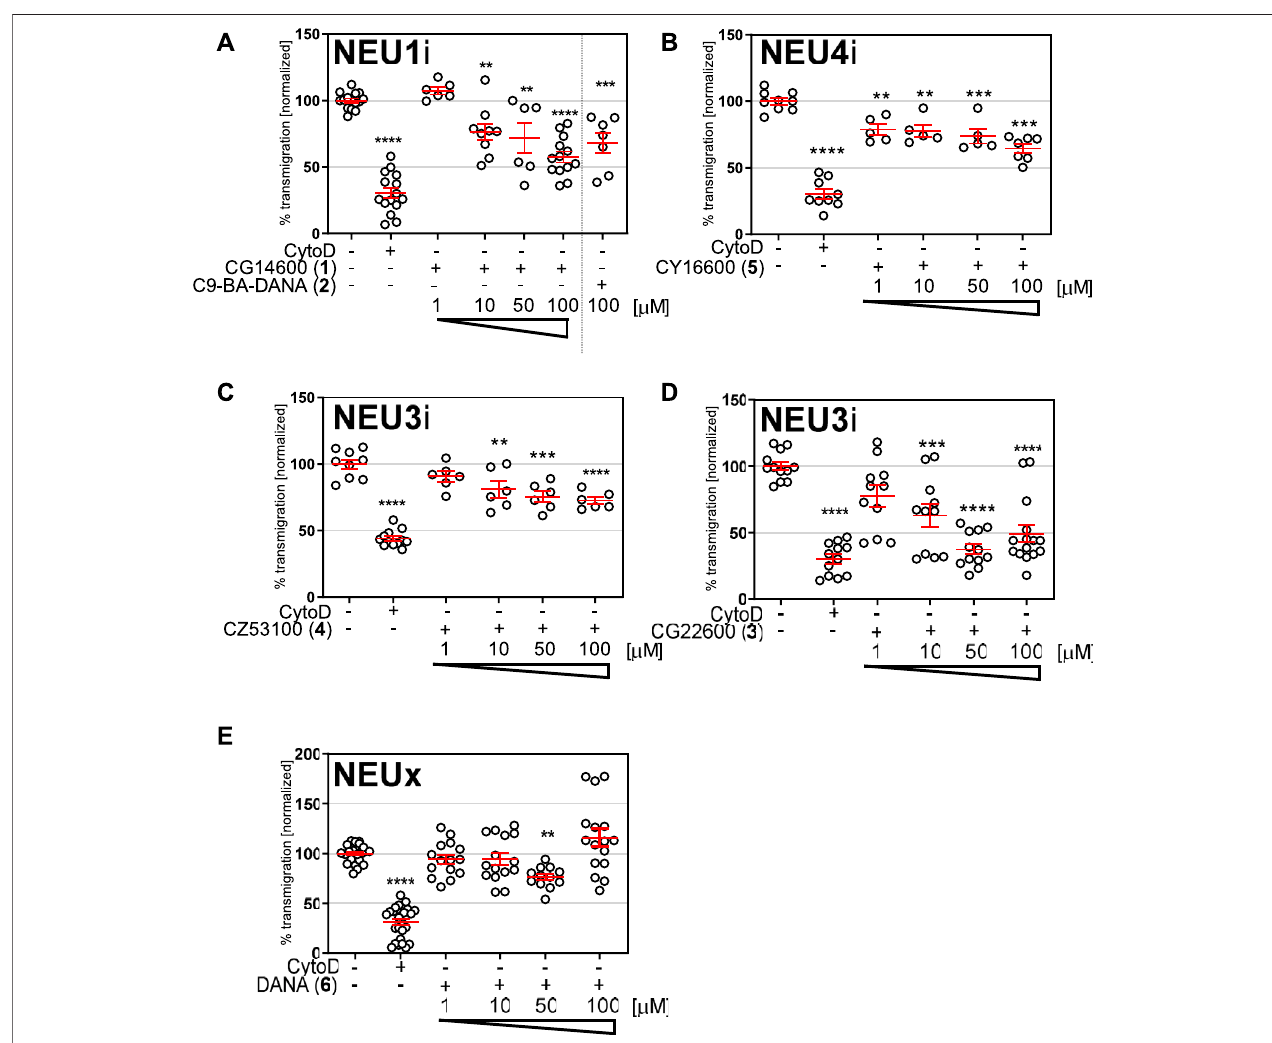
FIGURE 4 | Transmigration after treatment with NEU inhibitors. Transmigration experiments were carried out with a FN-coated transwell plate. The bottom chamberwasloadedwithserumandcytokine-freemediaasanuntreatedcontrol;CytoDwasusedasanegativecontrolfortransmigration.Allotherexperimentsuseda lowerchambercontainingcytokineandserumasattractant.Cellswereloadedinthetopwellwiththeindicatedconcentrationofinhibitorsfor (A) NEU1, (B) NEU4, (C,D) NEU3, or (E) non-speci fi c inhibitor DANA 6 . Cells were allowed to transmigrate for 21 h and were counted by fl ow cytometry. Data shown for inhibitors include six technicalreplicates and twobiologicalreplicates;and arerepresentedasmean ±SEMand compared tocontrolusing one-wayANOVAfollowedbyDunnett ’ spost-hoc analysis (**** p ≤ 0.001; *** p < 0.005; ** p < 0.01).